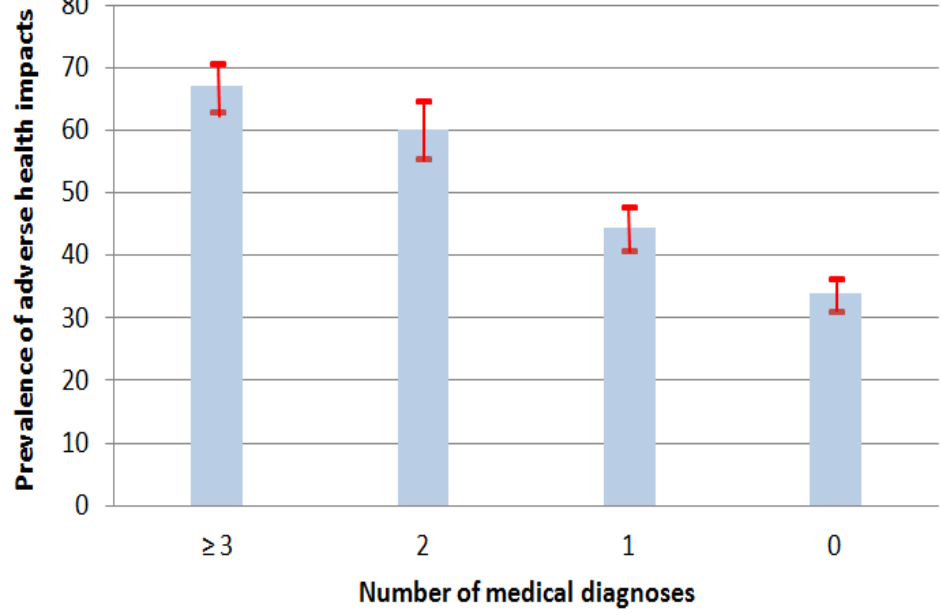
Figure 3. Prevalence of perceived adverse health effects during very hot and humid summer conditions, (with 95% confidence intervals), by number of reported medical diagnoses.